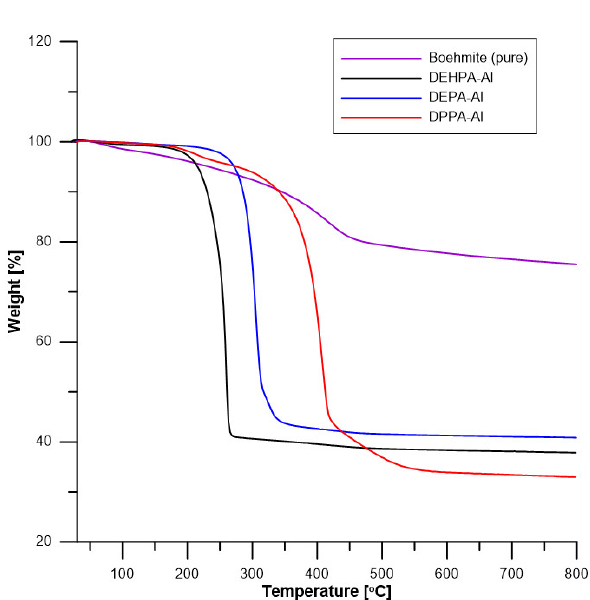
Figure 6. TG curves of boehmite and hybrids (in helium).